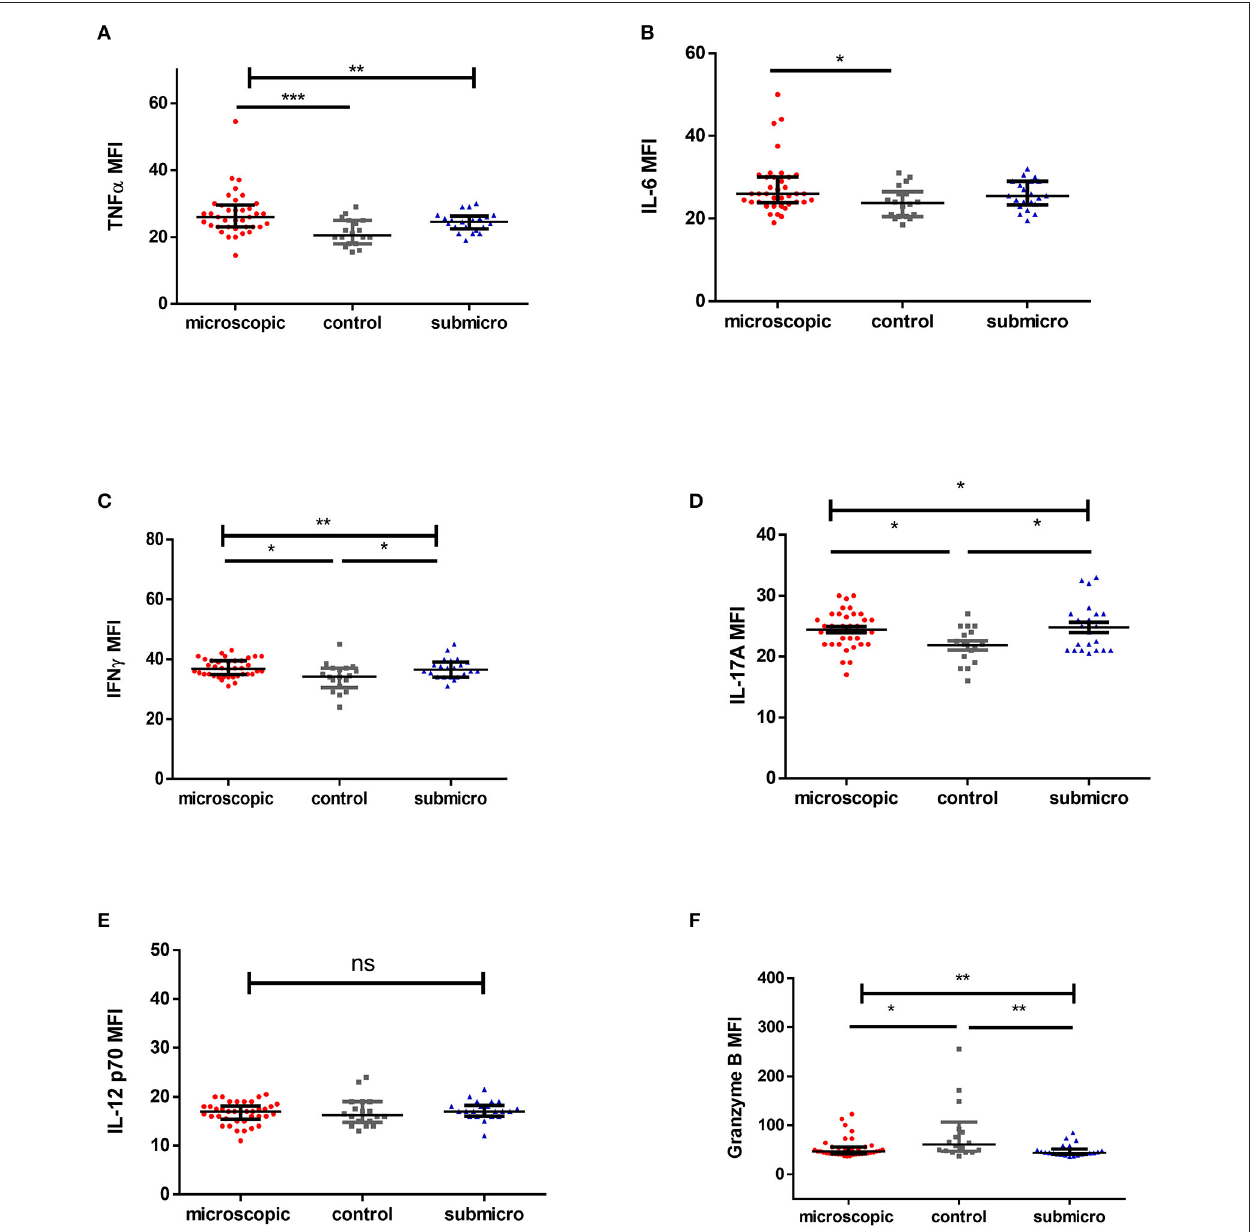
FIGURE 1 | Profile of pro-inflammatory mediators during microscopic and submicroscopic malaria. Scatter plot graphs are plotted showing the median fluorescence intensities (MFI) of (A–F) TNF- α , IL-6, IFN- γ , IL-17A, IL-12p70, and Granzyme B in plasma samples collected from uninfected controls ( n = 18), patients with microscopic asymptomatic malaria ( n = 38) and submicroscopic malaria ( n = 22). Plots show median and interquartile ranges. Significant differences are denoted by * p < 0.05, ** p < 0.01, *** p < 0.001, ns = not significant.